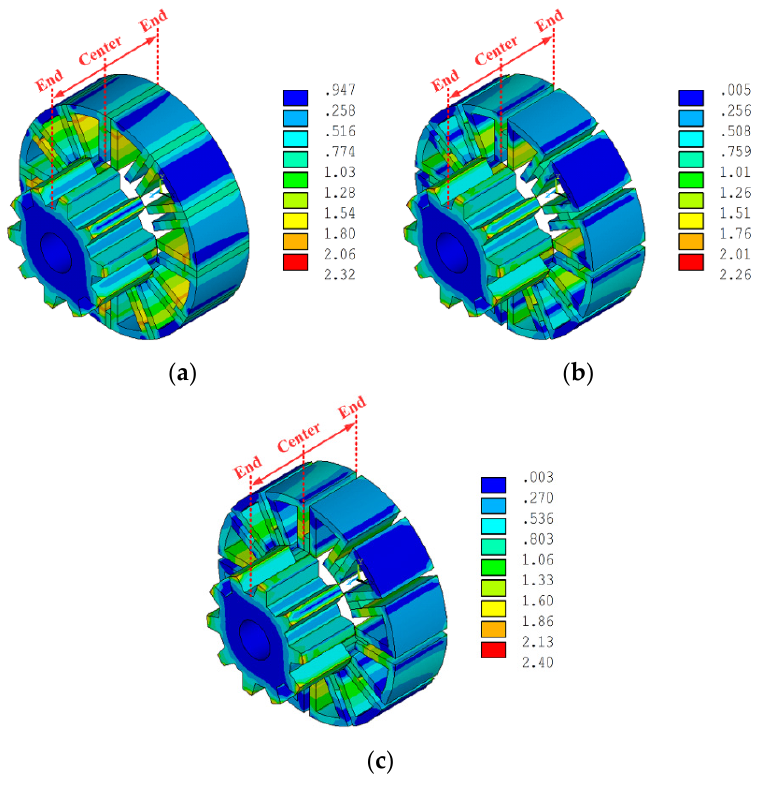
Figure 4. 3D FEA obtained flux density distributions due to NdFeB PMs only. ( a ) PM ‐ top; ( b ) PM ‐ bottom; 3D FEA obtained flux density distributions due to NdFeB PMs only. ( c ) PM ‐ middle ‐ 1 & ‐ 2. ( b ) PM-bottom; ( c ) PM-middle-1 & -2. Table 2. No ‐ load 3D end ‐ effect coefficients k end . Table 2. No-load 3D end-effect coefficients k end